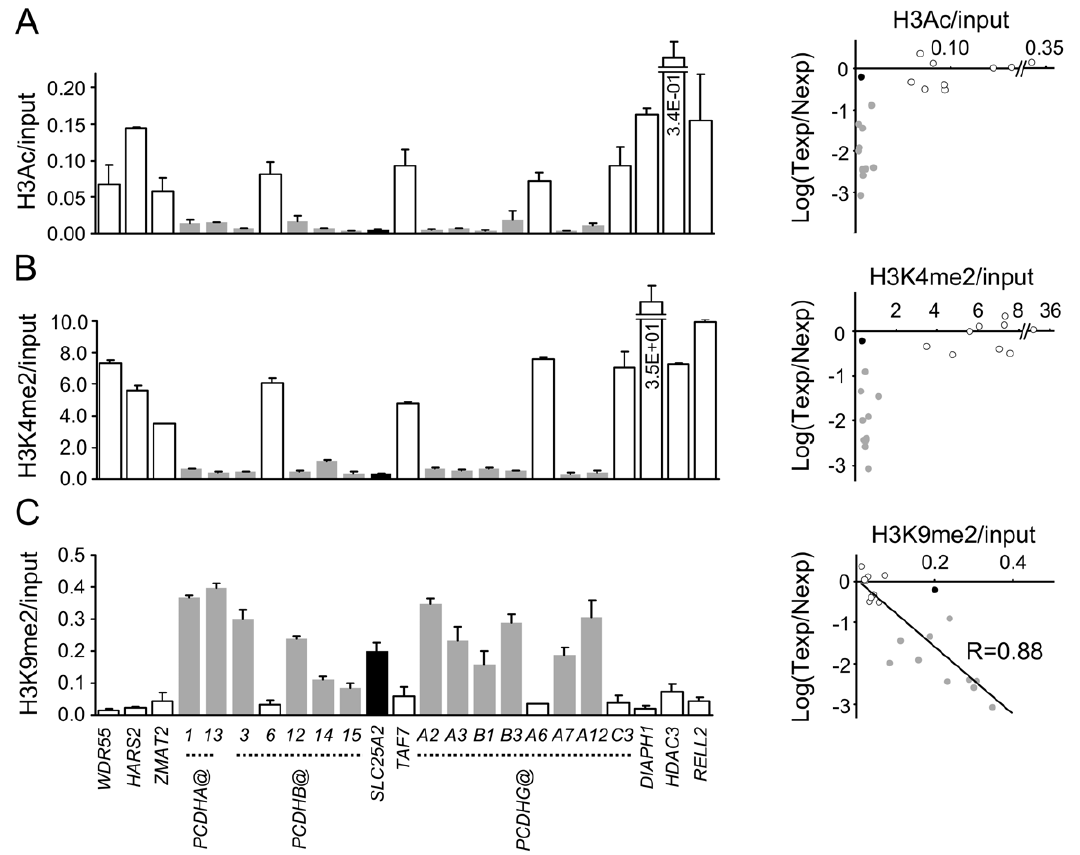
Figure 3. Hypermethylation across the chromosome 5q31 LRES is associated with specific histone modifications. Bar charts (left) show ChIP–quantitative PCR measuring relative levels of specific histone modifications at individual gene loci across the 5q31 locus in WiT49 cells. (A) H3Ac ChIP, (B) H3K4me2 ChIP, (C) H3K9me2 ChIP, all expressed relative to input DNA. Scatter plots (right) show the relationship between relative gene expression levels and histone modifications at each gene. The x-axis shows specific histone levels relative to input DNA, and the y-axis shows mRNA expression in WiT49 cells (Texp) relative to average mRNA expression in 4 fetal kidney samples (Nexp). Grey bars/datapoints signify genes hypermethylated in WiT49, open bars/datapoints show unmethylated genes, and the black bar/datapoint shows constitutively methylated SLC25A2